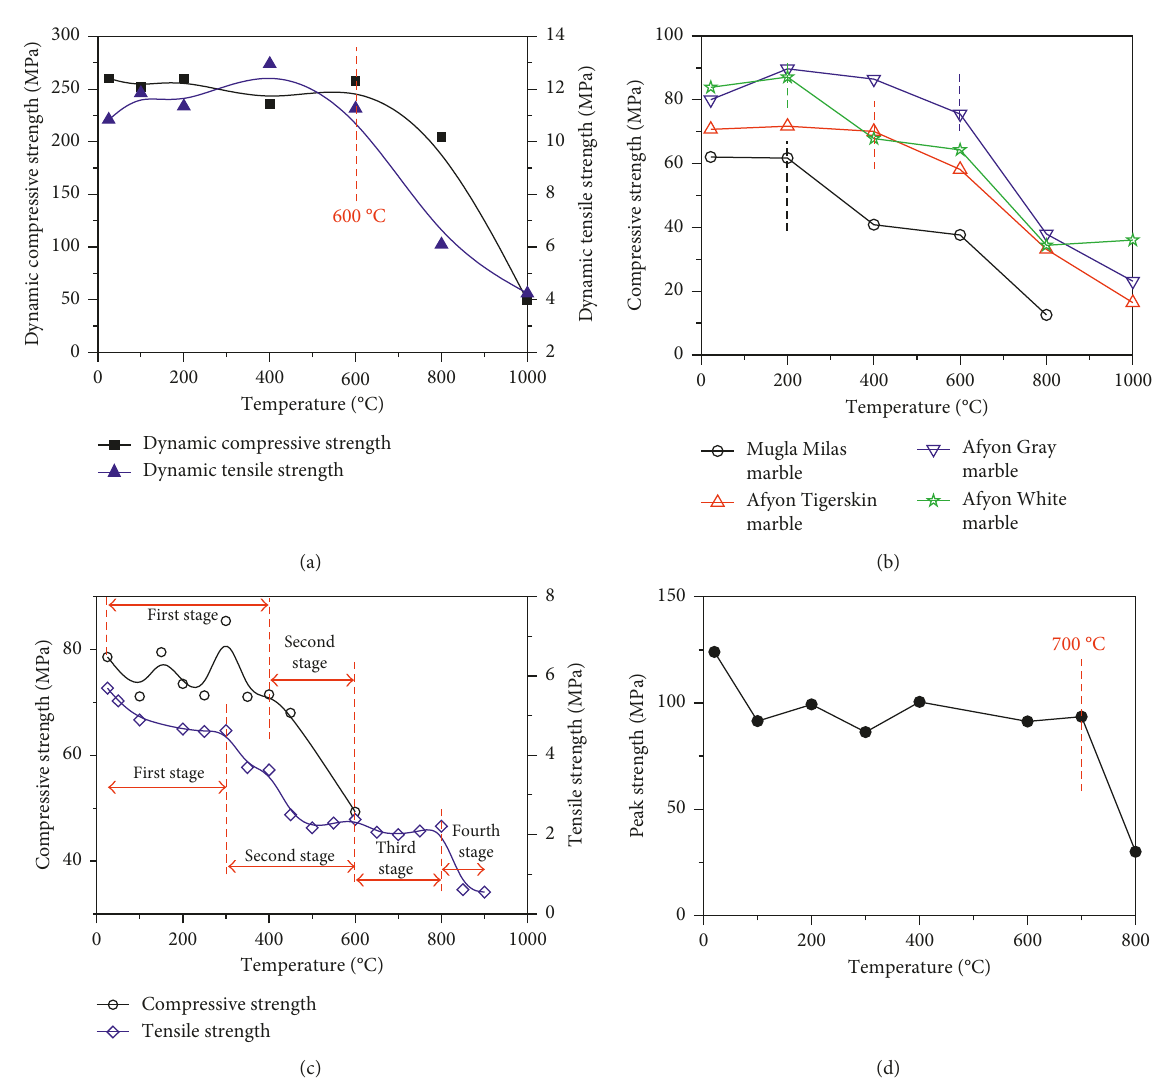
Figure 4: Variations of mechanical parameters of rocks with temperature: (a) dynamic compressive strength and dynamic tensile strength of marble [18], (b) compressive strength of marble [19], (c) compressive strength and tensile strength of Linyi sandstone [20, 21], and (d) peak strength of limestone